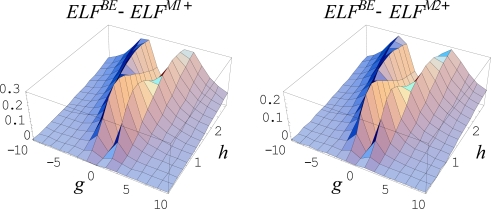
The same kid of representation as in Figure 11, yet here for marking the Markovian (M1+) and (M2+) behaviors of Equations (498) and (499), in left and right, respectively.